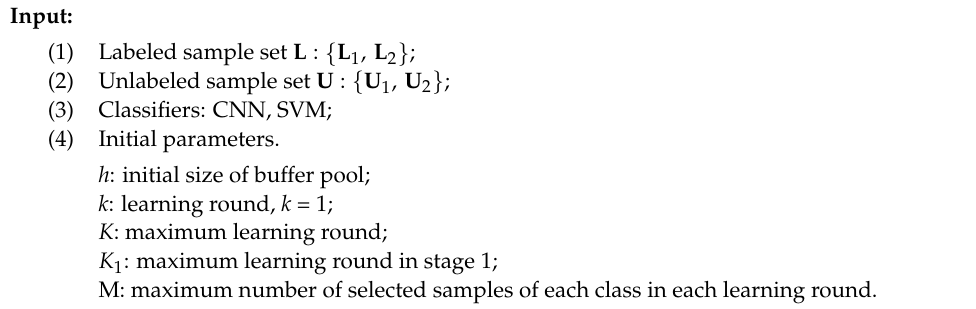
Algorithm 1: Co-training of CNN and